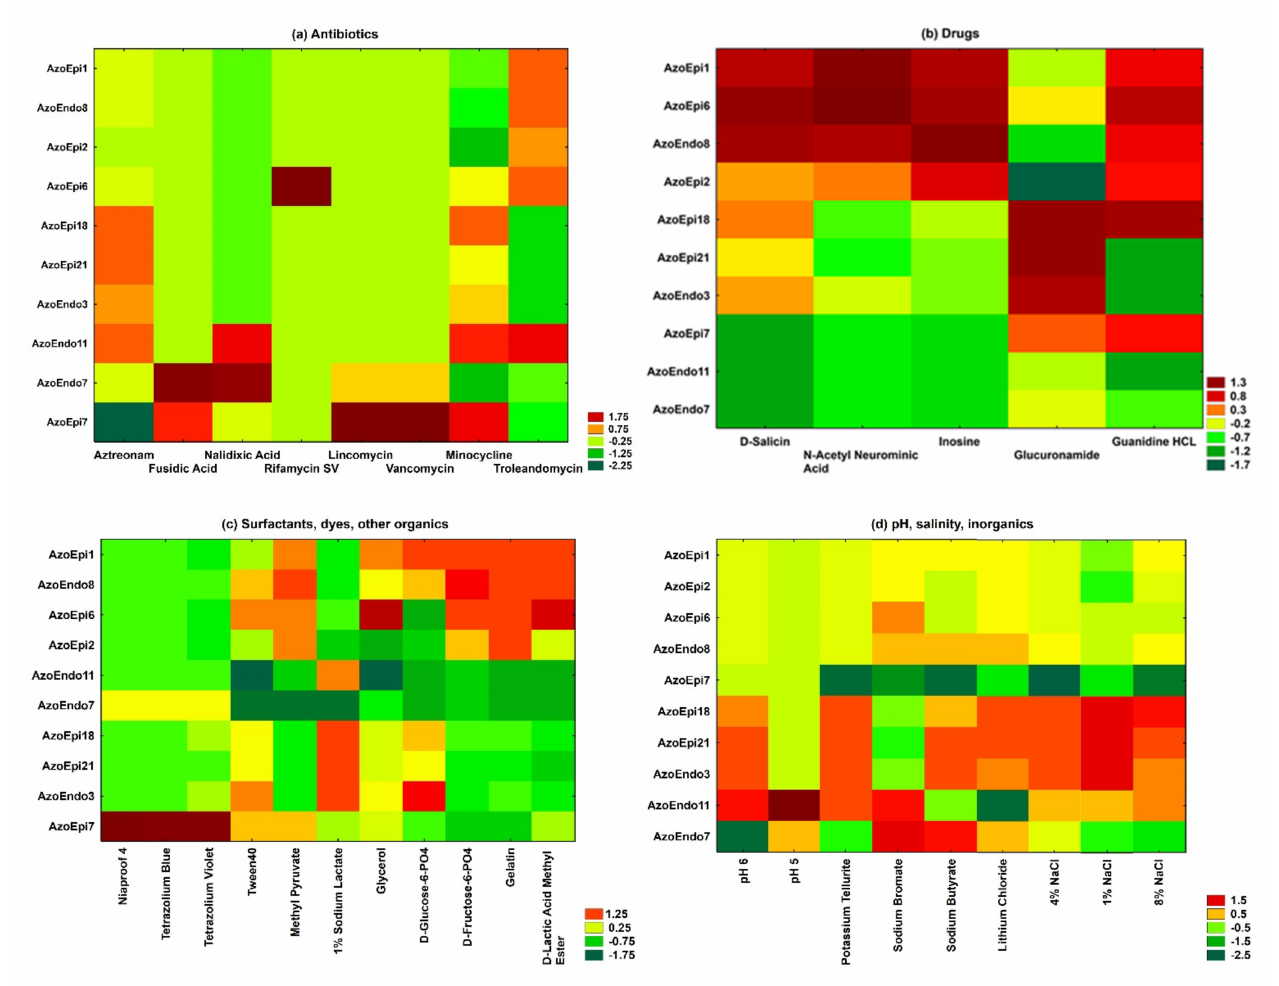
Figure 3. Heatmap of 10 strains showing metabolic profiles for some compounds: ( a ) antibiotics, ( b ) drugs, and ( c ) surfac- tants, dyes, and other organics, as well as ( d ) pH, salinity, and inorganics after 48 h of incubation. The relative use of selected substrates is depicted by color intensity, based on the legend next to the figure. The highest and lowest consumption rates are indicated by red and green color,